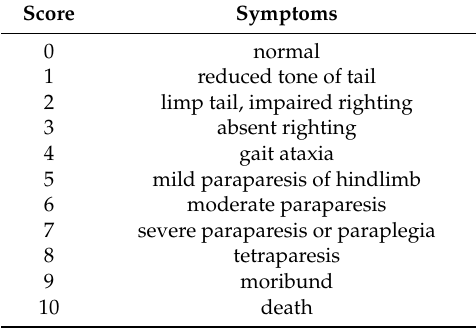
Table 1. List of symptoms and respective scores. Animals were scored according to this table by investigators blinded to animal treatment on every day of autoantibody (AB) application before the actual